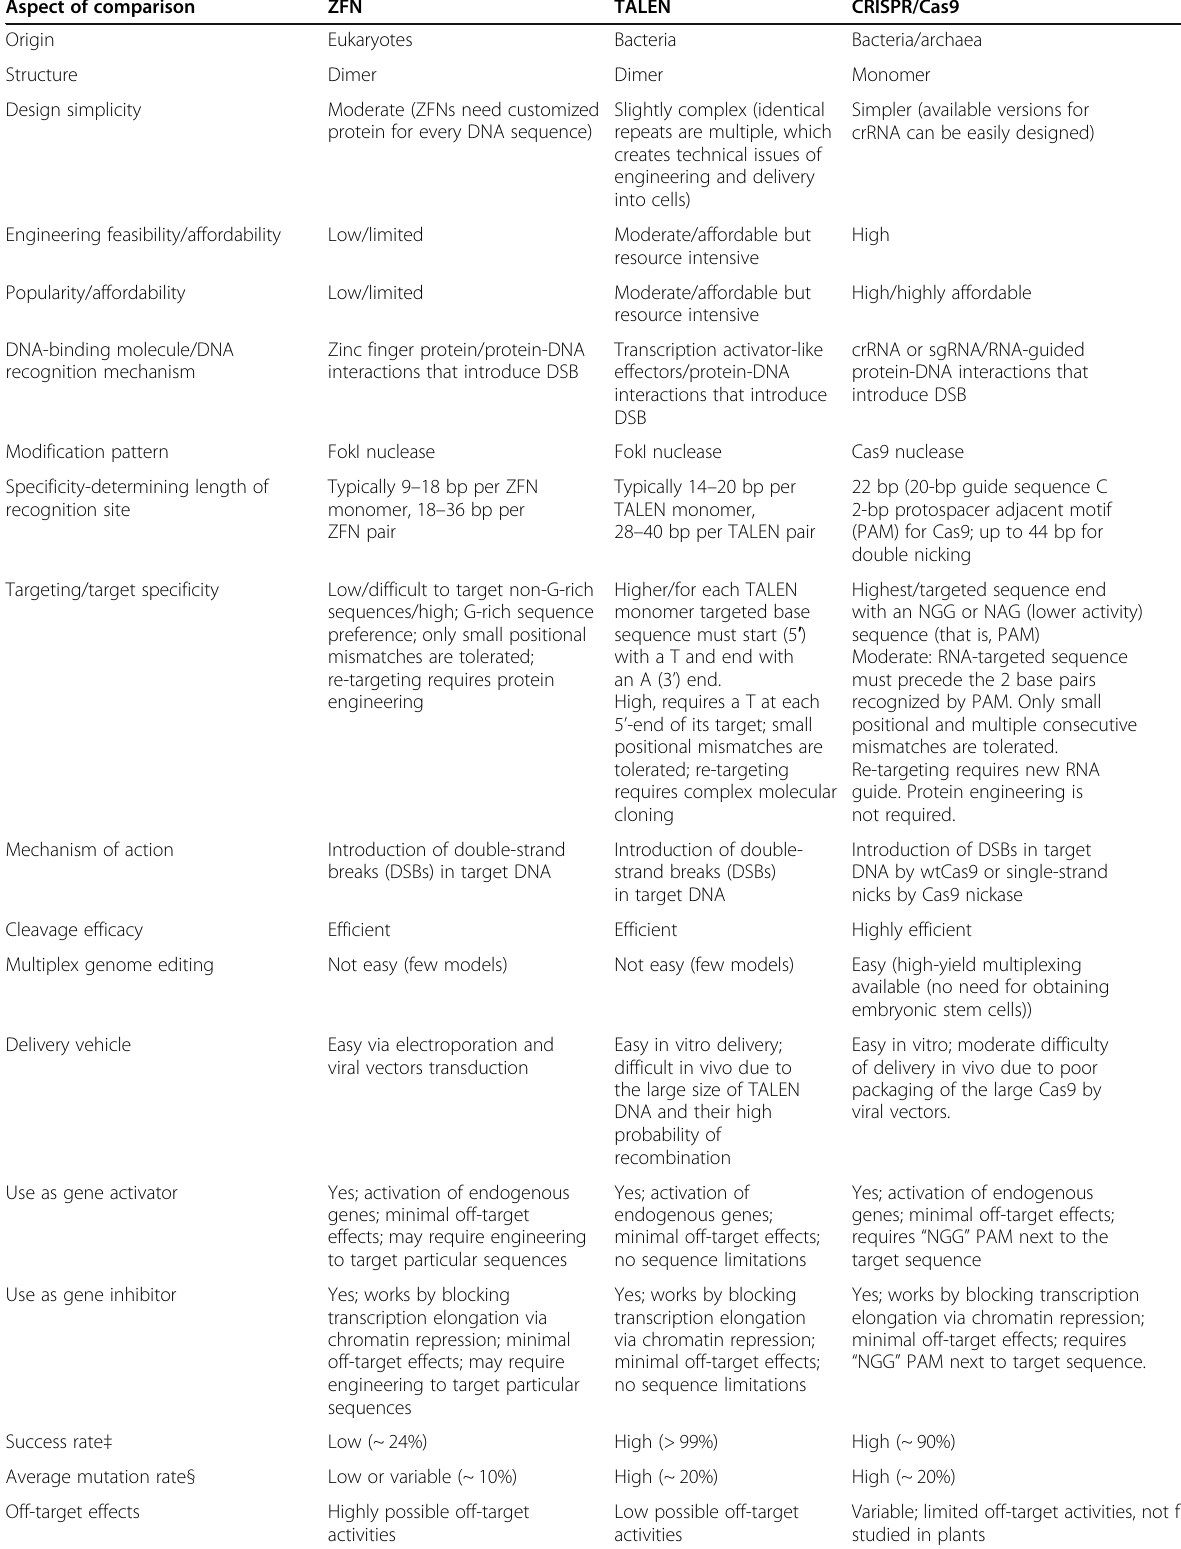
Table 1 Comparison of the three main currently used genome engineering platforms: ZFN, TALEN, and